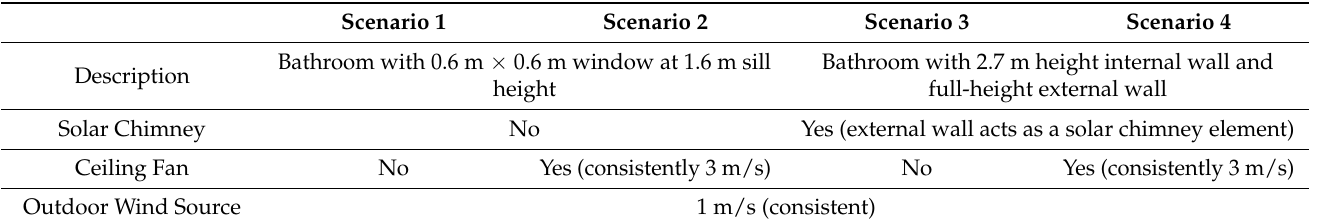
Table 5. Summary of four simulated scenarios based on opening type, presence of solar chimney elements, and presence of a ceiling